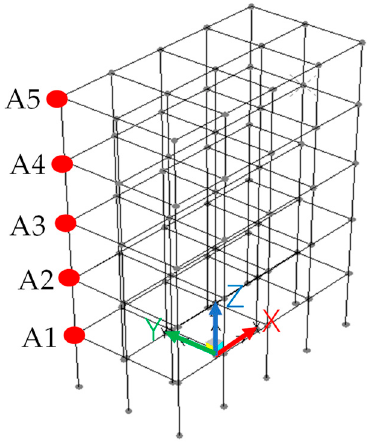
Figure 1. A 5-storey frame structure.